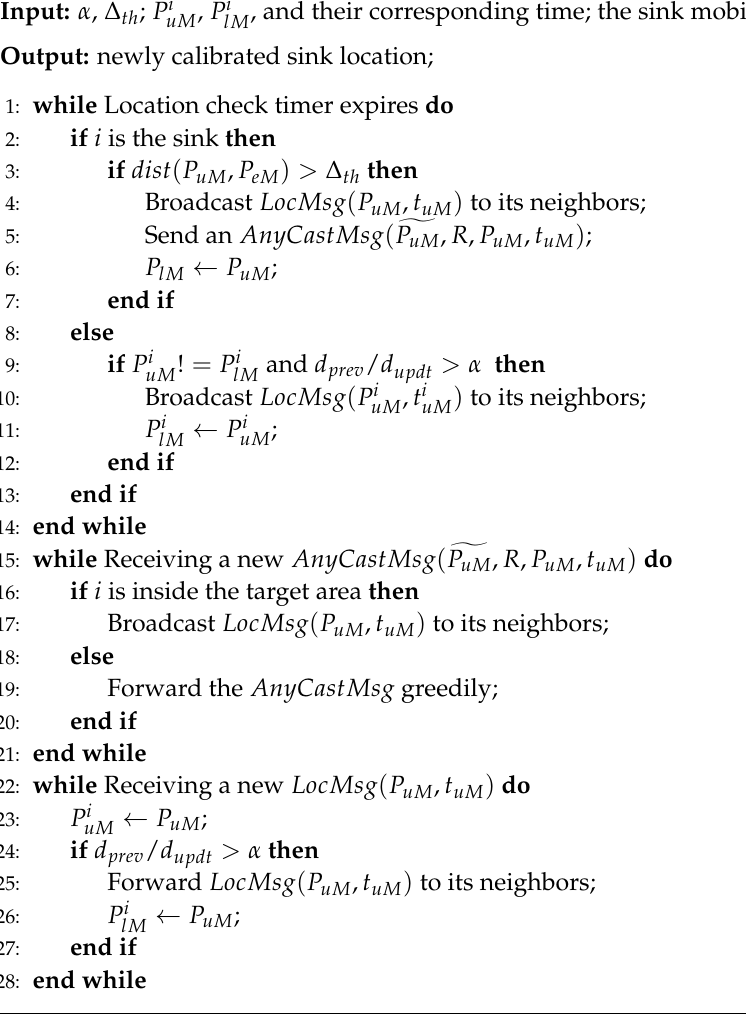
Algorithm 1 Sink location calibration algorithm at sensor node i